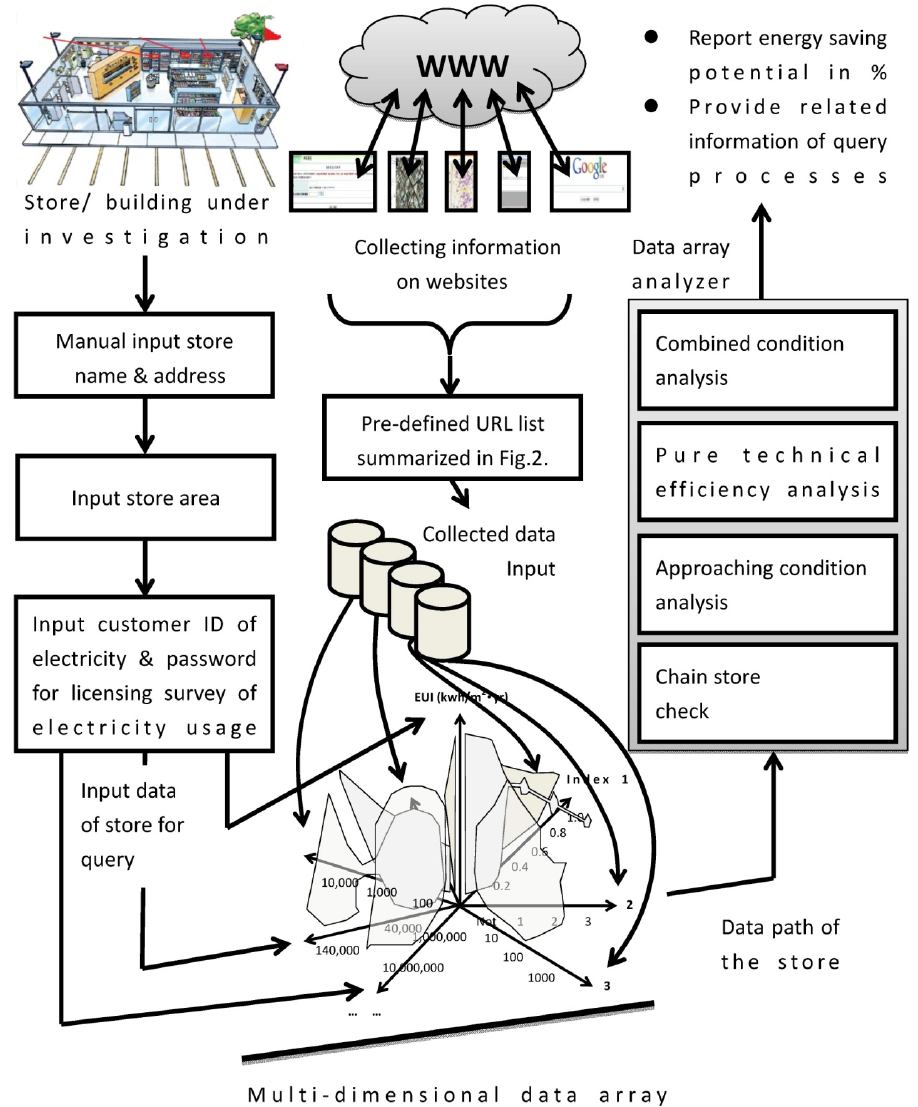
Figure 1. The schematic view of cloud sensor system: The left top panel and following panels show the manual input processes. From the middle top panel to down one, agent programs response for collecting data from websites with a pre-defined URL list. The pre-defined URL list will be summarized in Figure 2. It is noted that the special data architecture can be used as a sensor for investigating energy saving potentials. With the analysis algorithms shown on the right panel, the energy-saving potential is